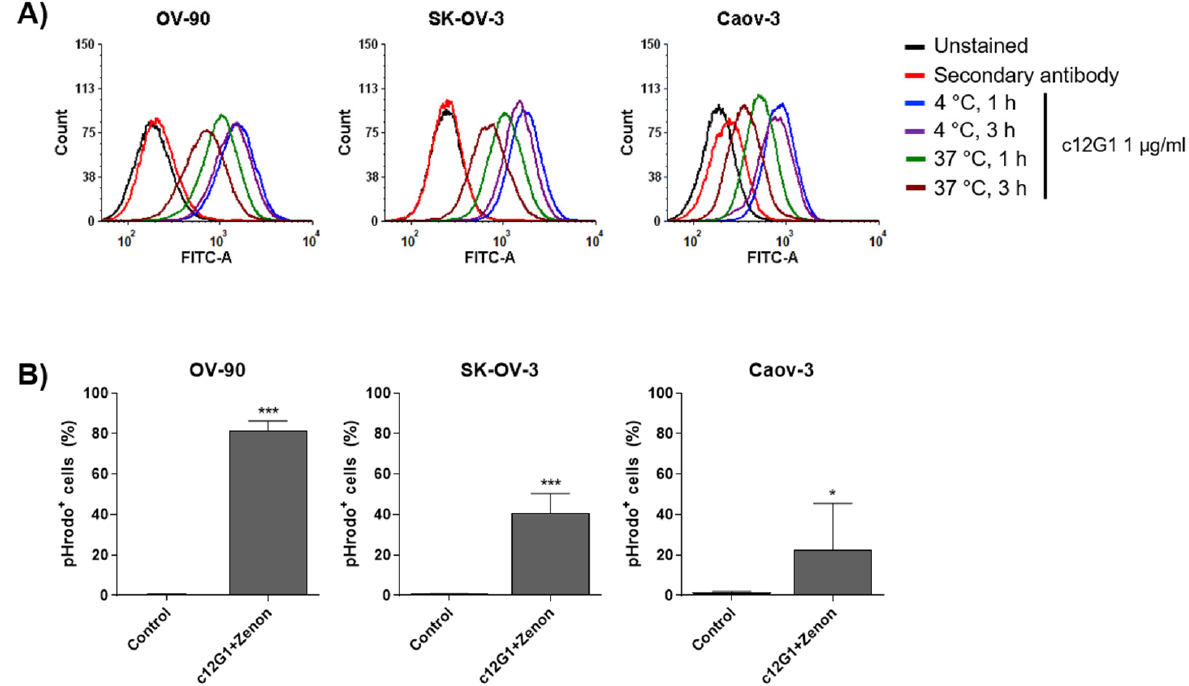
Figure 3. The c12G1 antibody is internalized into ovarian cancer cells. ( A ) Ovarian cancer cells were incubated in the presence or absence of c12G1 (1 µg/mL) at 4 °C or 37 °C, for 1–3 h, and then subjected to flow cytometer analysis. The fluorescence signal of the c12G1-nectin-2 complex on the cell surface decreased after incubation at 37 °C. ( B ) OV-90, SK-OV-3, or Caov-3 cells were treated with the c12G1/Zenon™-conjugated anti-Fc FAB complex for 15 h, following which the Zenon™-positive cells were analyzed using FACS (* and ***, vs. control). All experiments were independently repeated at least three times. * p < 0.05, *** p < 0.0001.